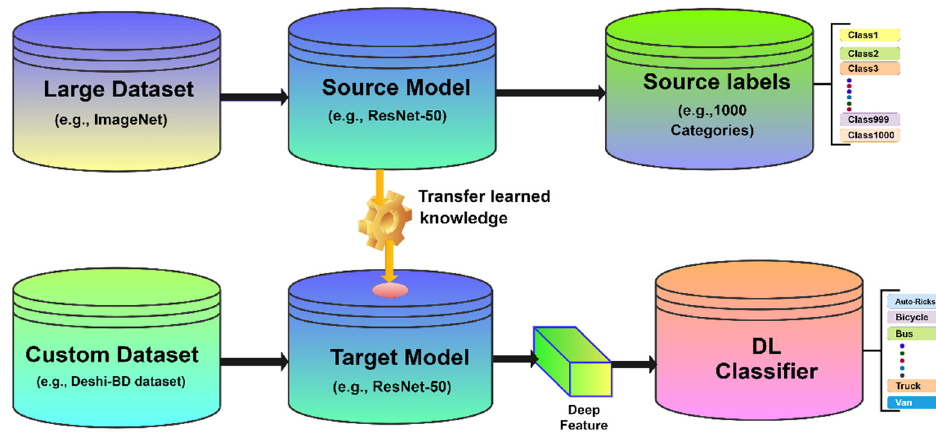
Figure 4. Transfer learning concept.